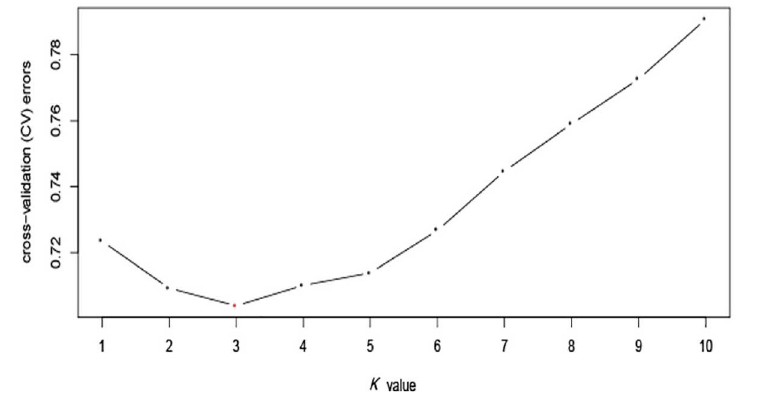
Fig 2. ADMIXTURE estimation of the number of groups for K values ranging from 1 to 10.